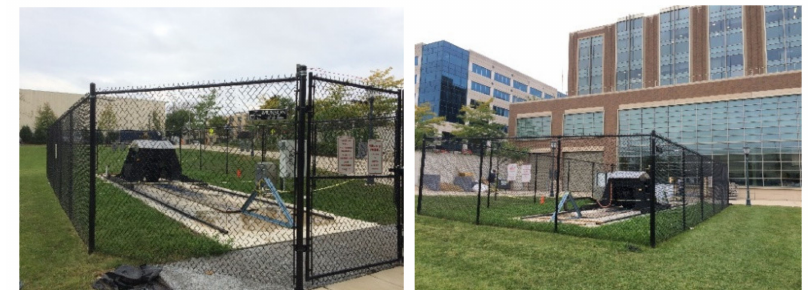
Figure 6. Heavy vehicle simulation (HVS) test facility located at Marquette